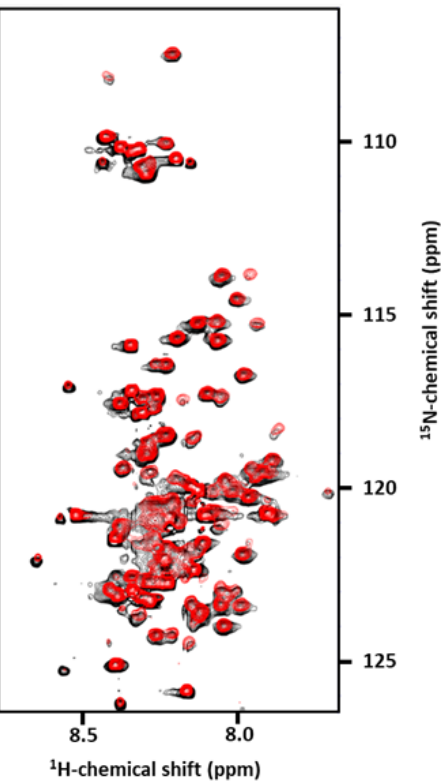
Figure 5. Overlay of 1 H, 15 N-HSQC spectra of WT (black contours) and D313K (red contours). Spectra were recorded on a 700 MHz spectrometer with a cryoprobe. Sample conditions were 0.5 mM protein with 10 mM Tris, 30 mM NaCl, and 1 mM TCEP, at pH 4.0 and a temperature of 298 K.